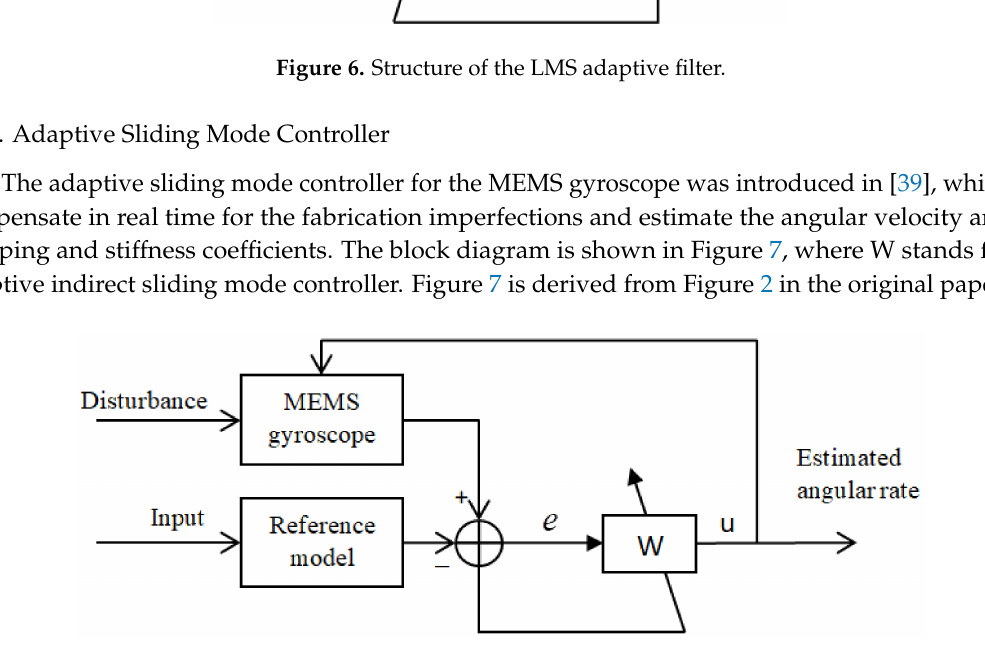
Figure 7. Indirect adaptive sliding mode control for an MEMS gyroscope. (W is the indirect sliding mode controller with an adaptive